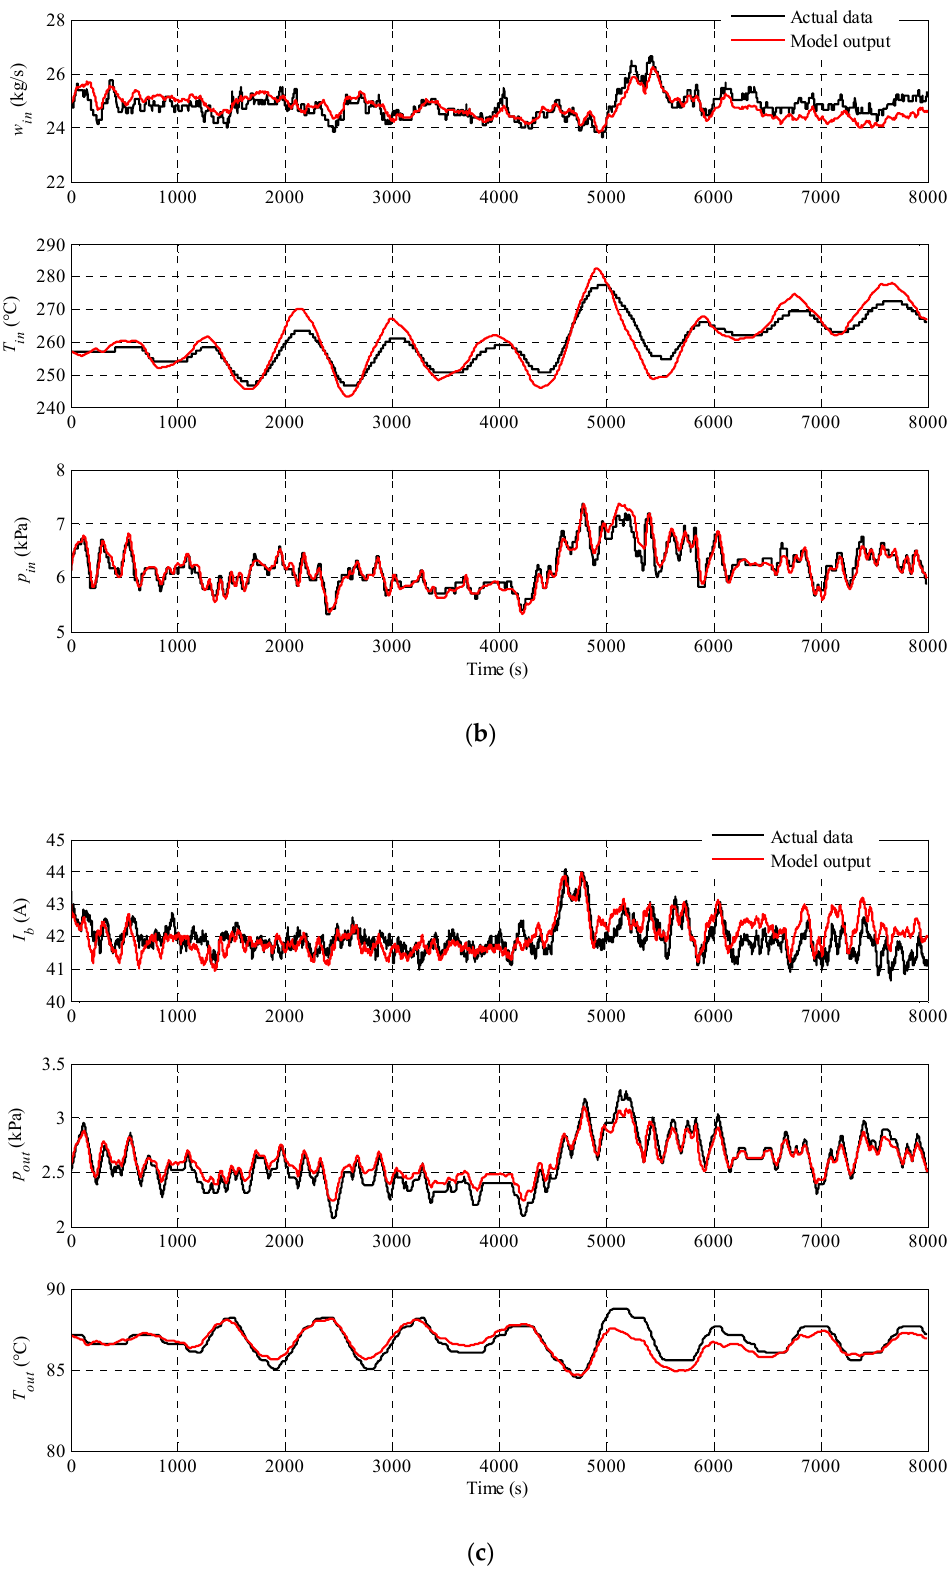
Figure 3. Comparison curves of each variable. ( a ) Trends of each input variable of the mill system. ( b ) Comparison curves of inlet air flow, temperature and pressure of primary air system ( c ) Comparison curves of grinding current, outlet air temperature and pressure of the mill.